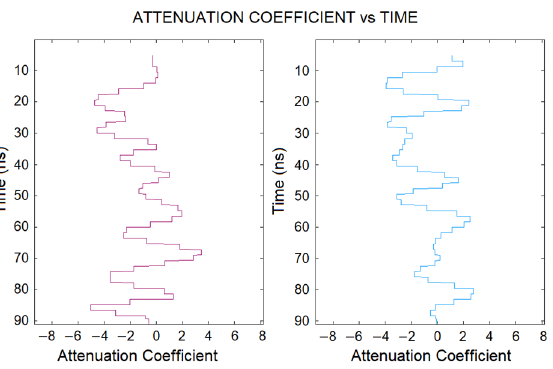
Figure 9. Stepped curves of attenuation coefficients obtained for two isolated traces.